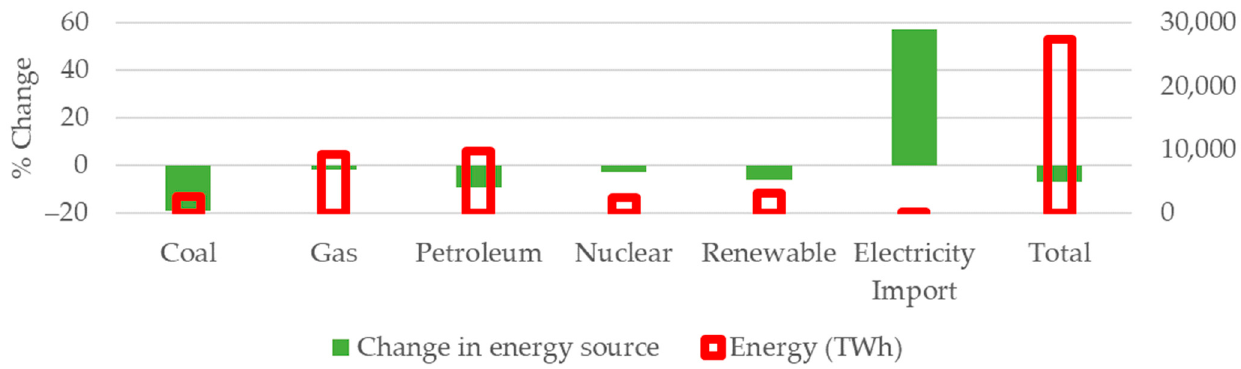
Figure 15. US 2020 energy totals by source and change relative to 2019 [30].